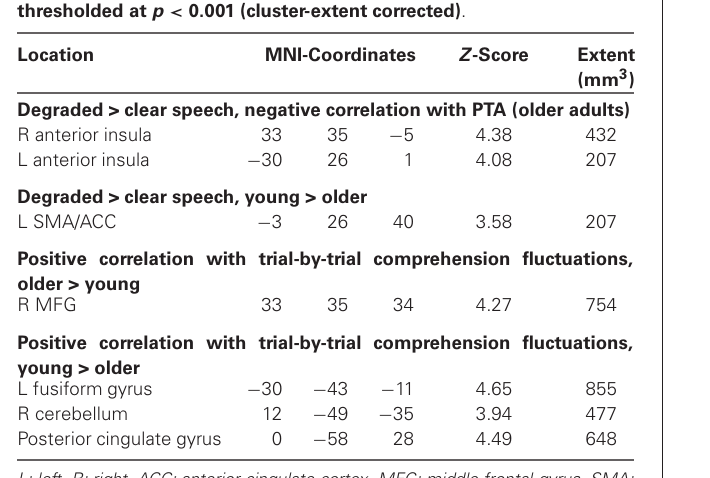
Table 2 | Overview of MRI activation clusters showing a correlation with hearing loss or significant group × condition interactions, thresholded at p < 0.001 (cluster-extent corrected) . Location MNI-Coordinates Z -Score Extent